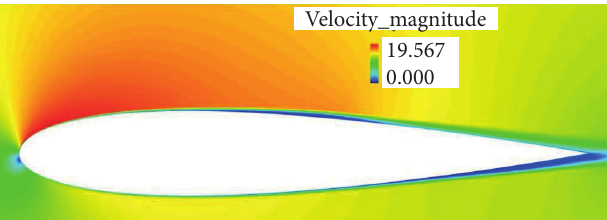
Figure 11. Velocity profile on NACA 0015 airfoil without VG in Plane 3 in Re c = 2.38 × 10 5 and AoA = 3.